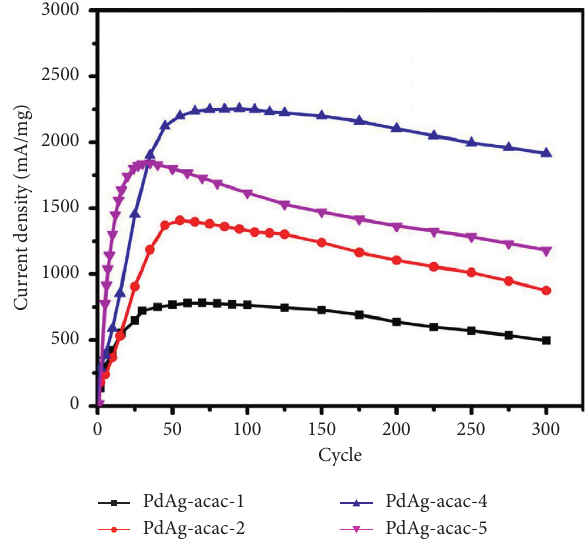
Figure 7: The variation of current density along with the cycle number for ethanol oxidation of the modified GCEs in 1M KOH/ 1 M C 2 H 5 OH solutions at a scan rate of